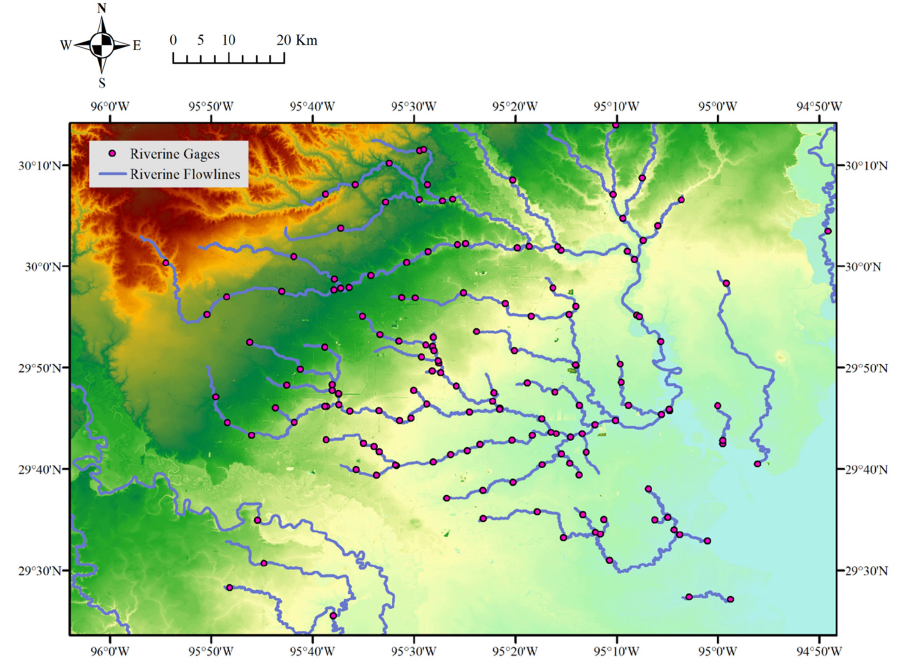
Figure 5. Riverine gauges and flow lines used for FEMA flood depth calculation.